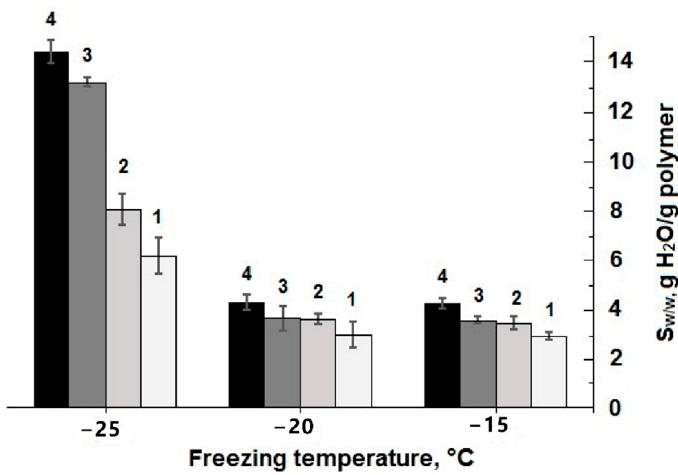
Figure 2. Swelling degree ( S w/w ) of the cryogels prepared from the initial solutions with different blood serum proteins concentrations (75.0 ( 1 ), 62.5 ( 2 ), 50.0 ( 3 ), and 37.5 ( 4 ) mg/mL) by their freezing at − 15, − 20, and − 25 °C.